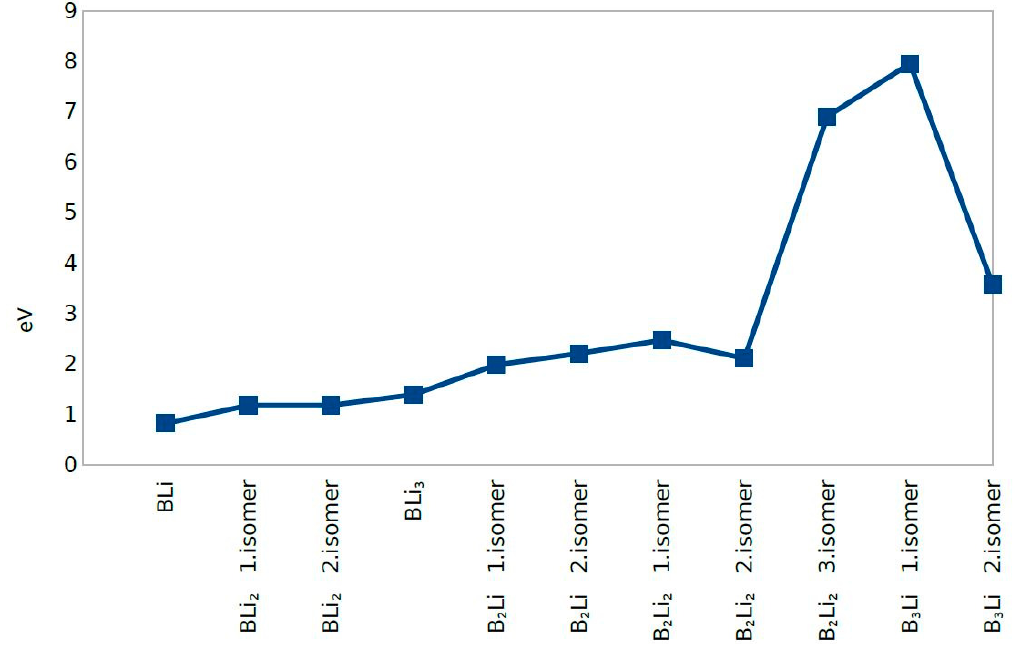
Figure 5. Binding Energy per Atom.